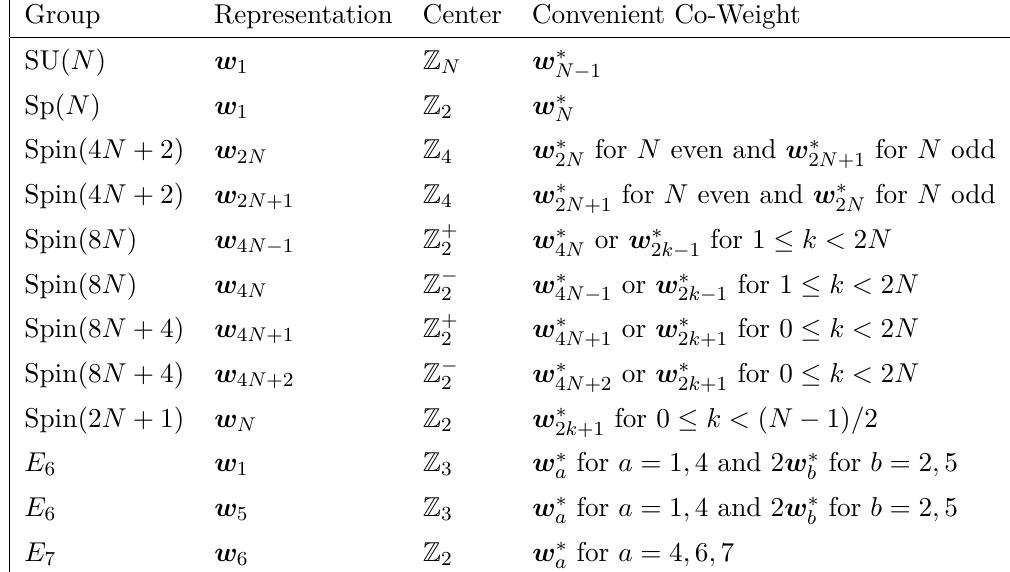
Table 3 . Centers of irreducible “convenient” representations of groups, listed by their highest weights, along with the “convenient co-weights,” which correspond to the generators (A.9) of the centers. These results are obtained in section